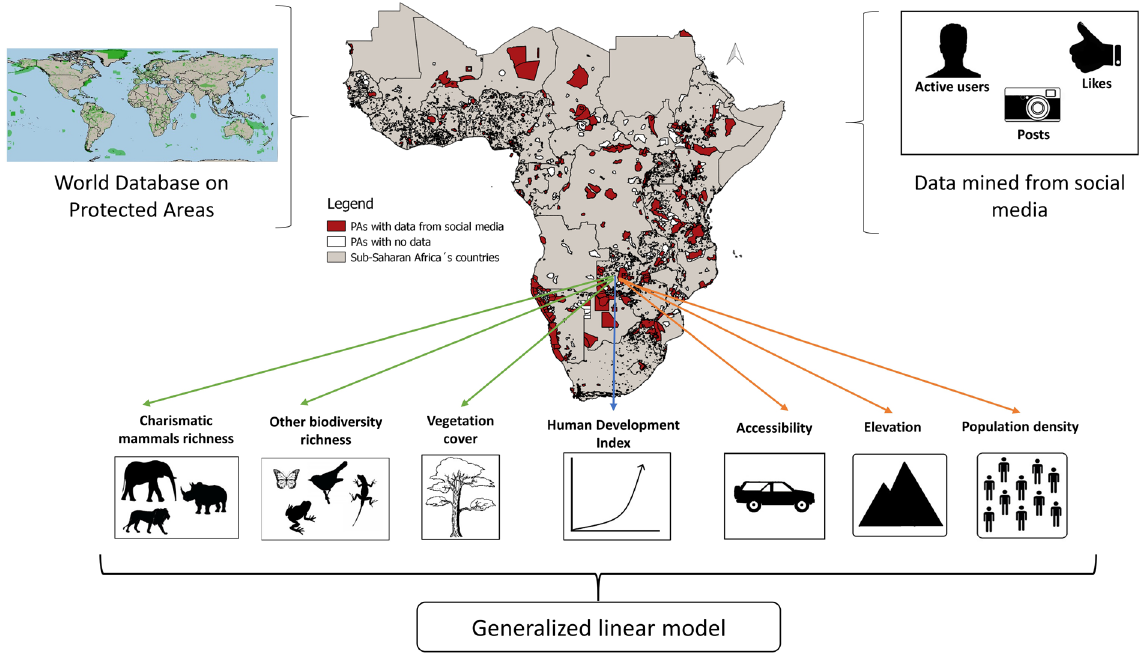
Figure 1. Logical framework of the study. For each protected area with data available from social media, biological (green arrows), geographical (orange arrows) and country level (blue arrow) attributes were also obtained and used in the generalized linear model as explanatory variables. Maps were created in QGIS 2.8.1 (URL http://www.qgis.org/en/site/). All images were generated by the